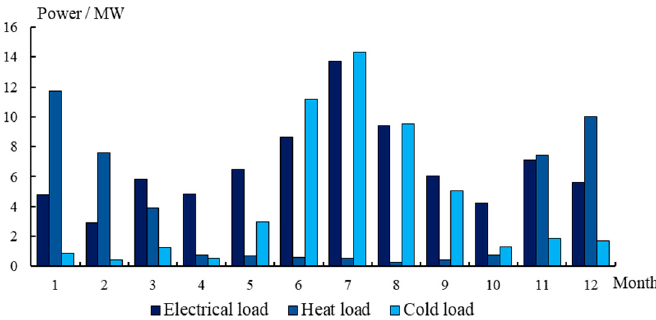
Figure 8. Maximum load distribution for each month of the year.